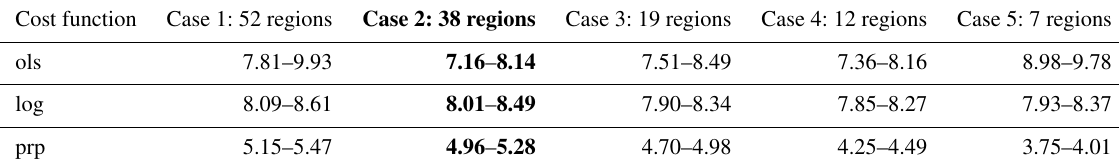
Table 4. Model global 228 Ra fluxes (10 23 atomsyr − 1 ) with different numbers of source regions. The standard case with 38 regions is in bold.